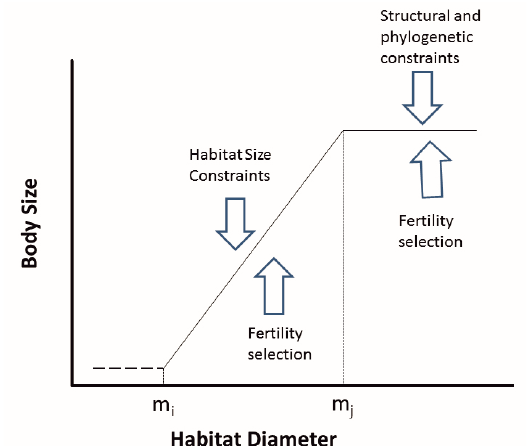
Figure 1. Hypothetical relationship between pore size (habitat diameter) in subterranean habitats and body size, with selective forces indicated by arrows. Below a minimum (m i ), there is not su ffi cient space for animals to occur without burrowing. Above a maximum (m j ), body size is likely constrained by other factors, such as phylogenetic and structural constraints. The relationship need not be linear but is presented as such for simplicity. From Pipan and Culver [24]. Used with permission of the National Speleological Society ( www.caves.org ).